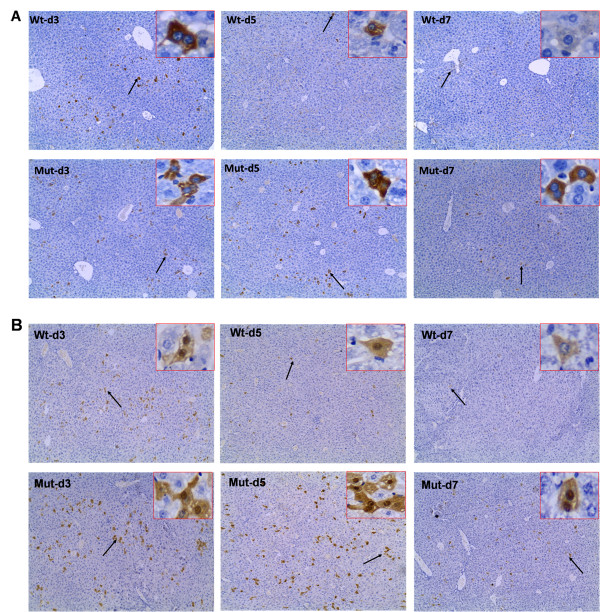
The expression of HBsAg (A) and HBcAg (B) immunohistochemistry detection in liver tissue sections. Mice liver sections on day 3, 5 and 7 after transfection were detected using specific antibody. The positive expressions were stained brown as shown by black arrow, which were magnified 400 times in the top right corner of these pictures (100×original magnification).